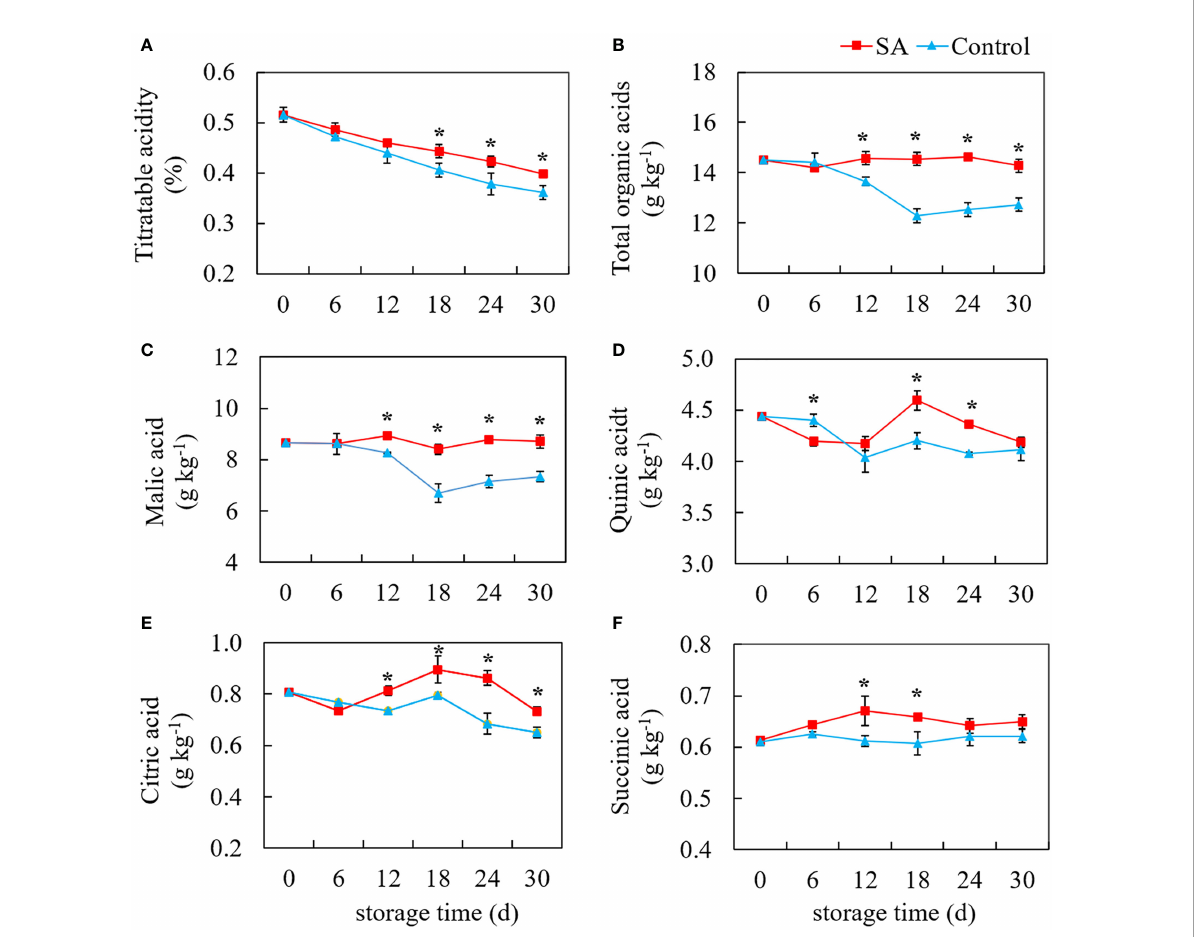
FIGURE 2 Effects of Salicylic acid treatment on organic acid of blueberry during cold storage. (A) , Titratable acidity (TA); (B) , total organic acid; (C) , Malic acid; (D) , Quinic acid; (E) , Citric acid; (F) , Succinic acid. Error bars represent the standard deviations of the means (n=3). The asterisks show a signi fi cant difference between SA-treated fruit and control fruit ( P <